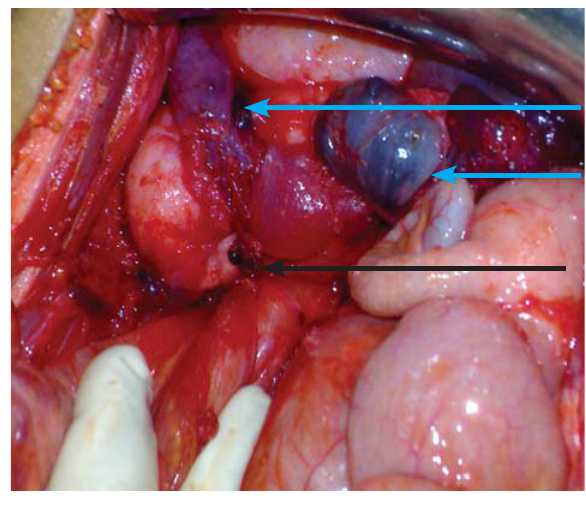
Figure 2: Operative photograph showing severe (cid:2) brosis over the Douglas pouch and pelvic cavity with chocolate cysts in the bilateral ovaries and intraperitoneal rupture of the left ovarian cyst (blue arrow) and grade IV endometriosis. The rectosigmoid junction was anteriorly entrapped by dense (cid:2) brotic tissue (black arrow). The upper rectum was anteriorly entrapped by dense (cid:2) brotic tissue which distorted and caused a stenosis of the lumen. The surgery included adhesiolysis, anterior resection with diverting end colostomy/distal mucous (cid:2) stula and total abdominal hysterectomy with bilateral salpingo-oophrectomy. The post-operative period was uneventful. On the tenth post-operative day she was discharged on Danazol 200 mg twice daily for six months. Histopathological examination of the resected specimen revealed endometrial glands and stroma embedded in the submucosa, muscle, subserosal and serosal surface of the rectum and both the fallopian tubes and ovaries (Figure 3).